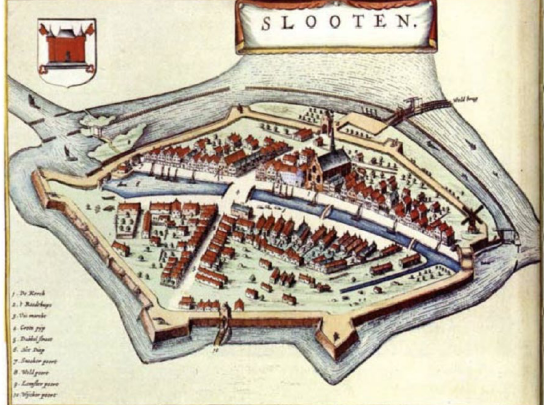
Figure 1. Historical image of the village of Sloten, 1664 (Pouderoyen Compagnons, 2012) .